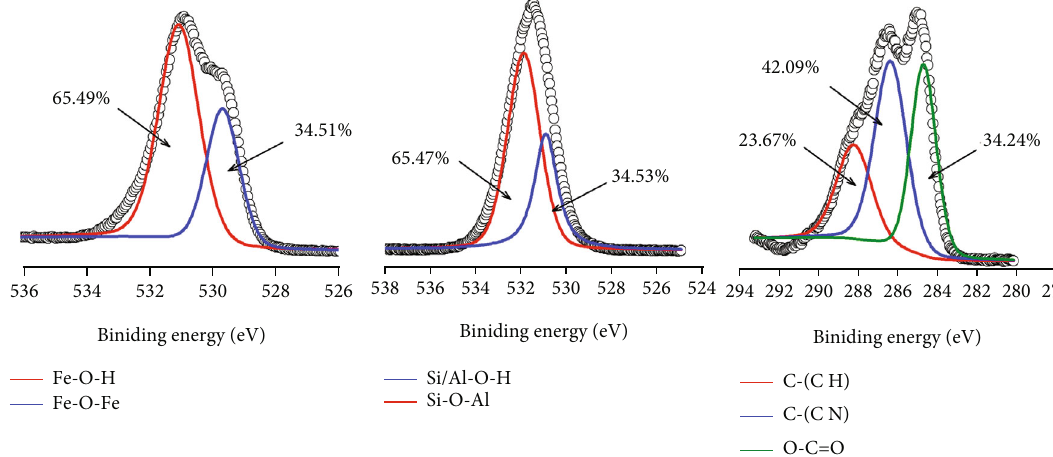
Figure 4: High-resolution O 1s XPS spectra of goethite and kaolinite and C 1s XPS spectrum of the Bacillus cereus cell.